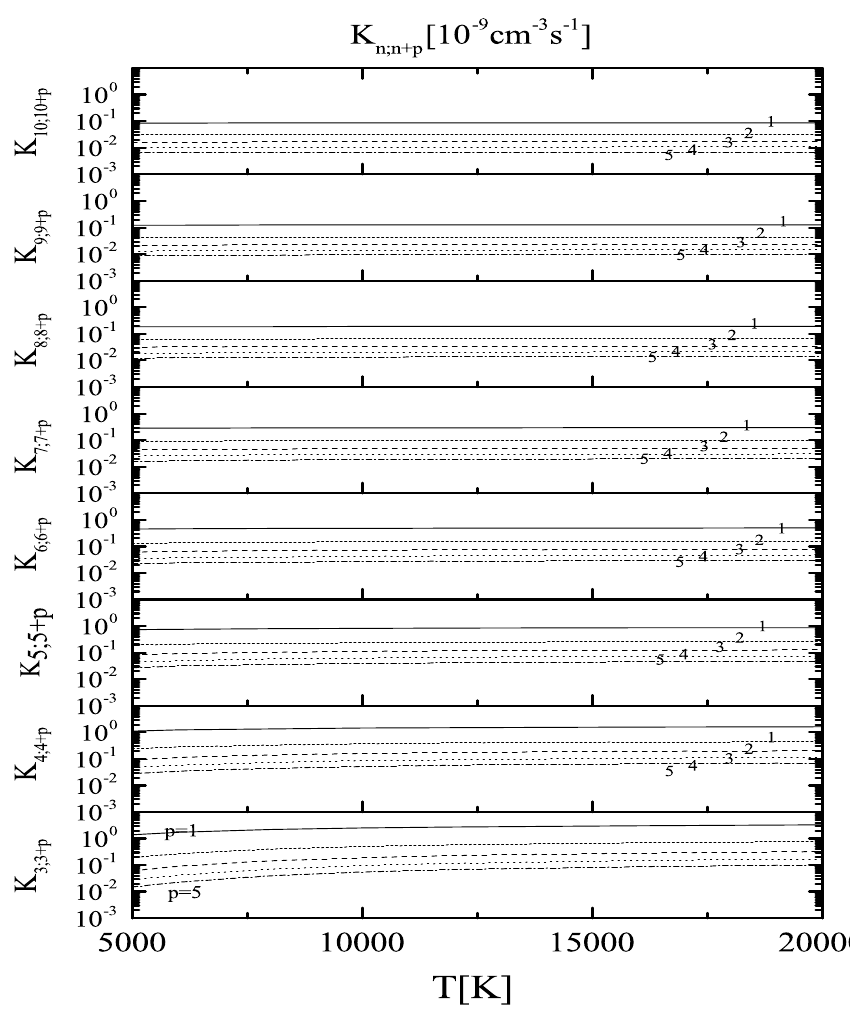
Figure 8. Collisional excitation helium rate coefficients K n ; n + p ( T ) for the transitions between the states with 3 ≤ n ≤ 10, 1 ≤ n (cid:48) − n ≤ 5 as a function of n and T . p = n (cid:48) − n